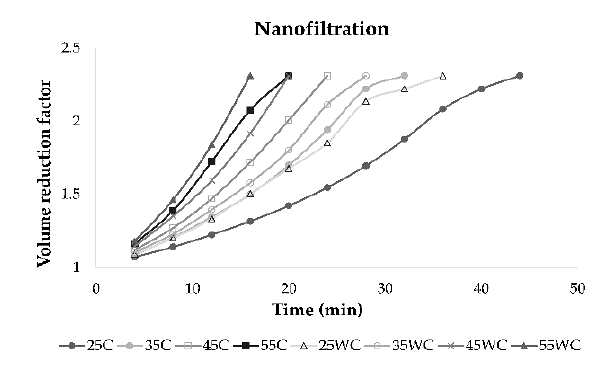
rt ) on permeate flux (L/m 2 h) during concentration of Cabernet Sauvi-